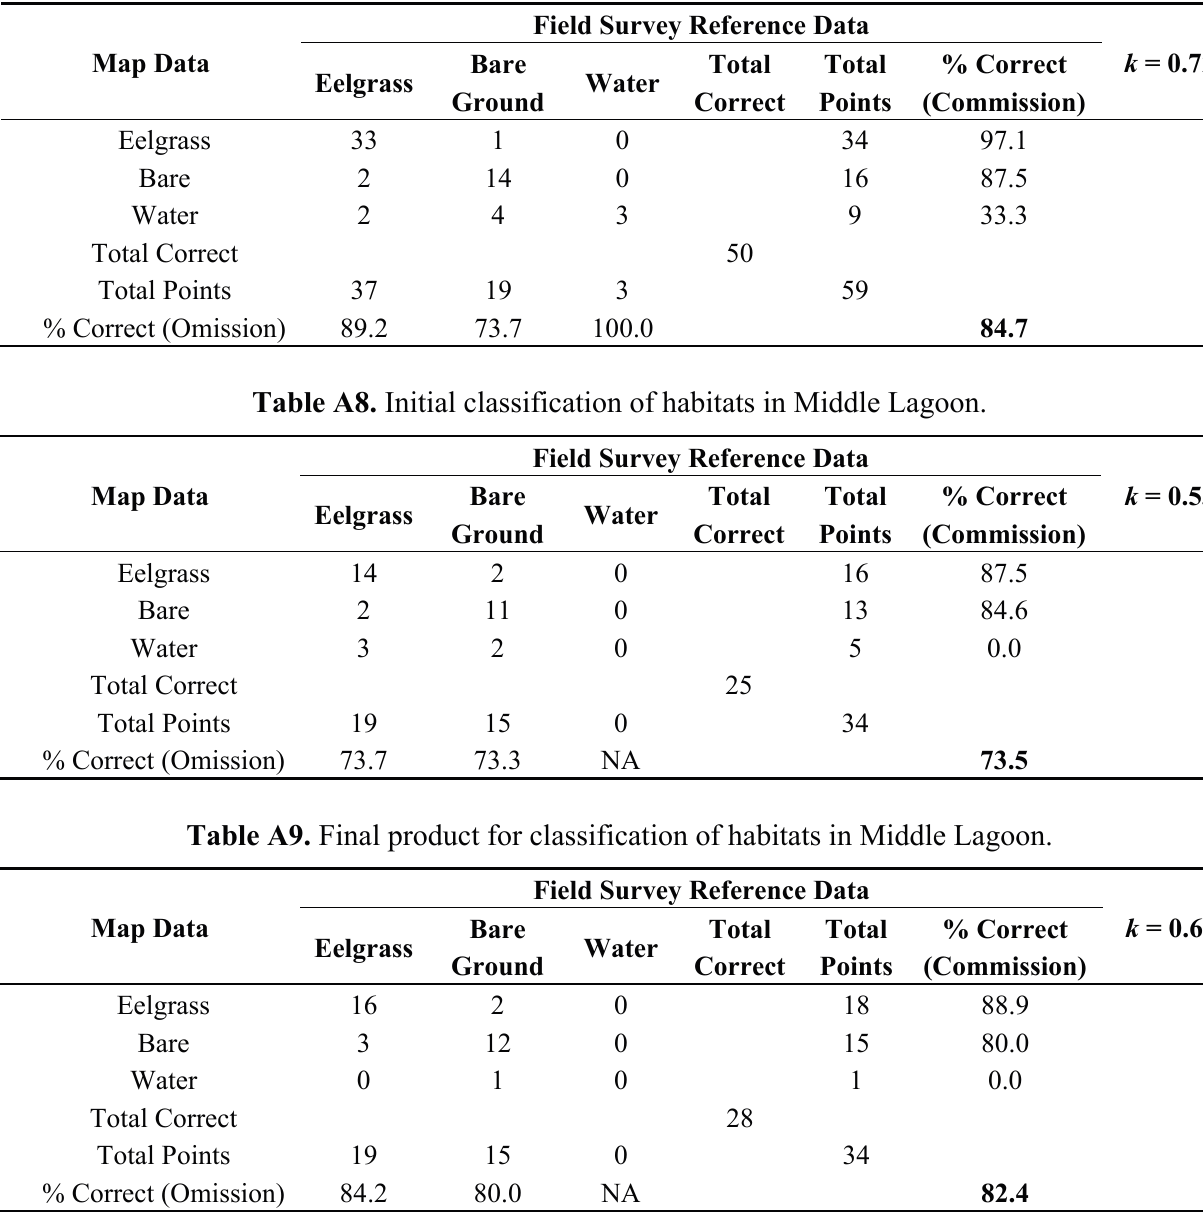
Table A7. Final product for classification of habitats in Big Lagoon.